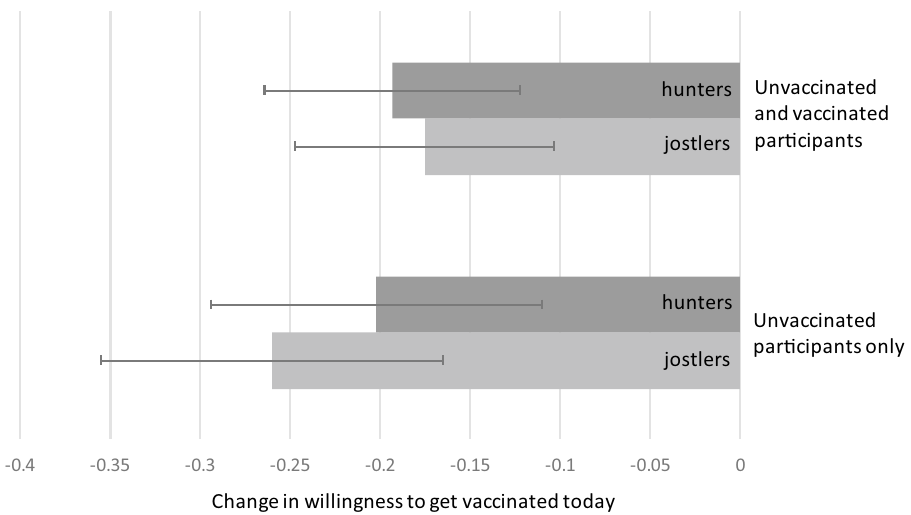
Figure 1. Effect of the hunters and jostlers treatments on the willingness to get vaccinated as soon as the vaccine becomes available [VAXTODAY]. The upper two bars of the hunters and jostlers treatments on all participants (Column (1) in Table 1, panel A) the lower two bars show the effect of the treatments on unvaccinated participants only (Column (1) in Table 1, panel B). Error bars denote robust standard